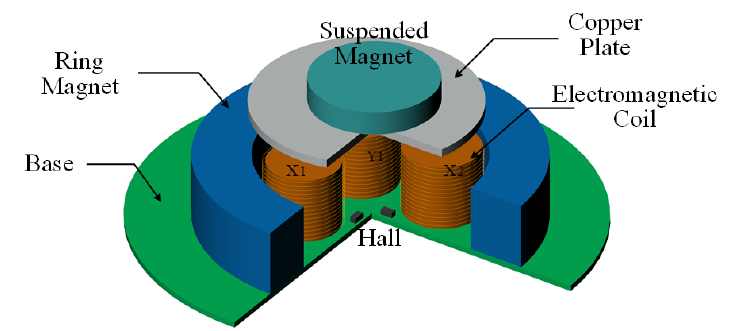
Figure 1. Magnetic suspension system model diagram.